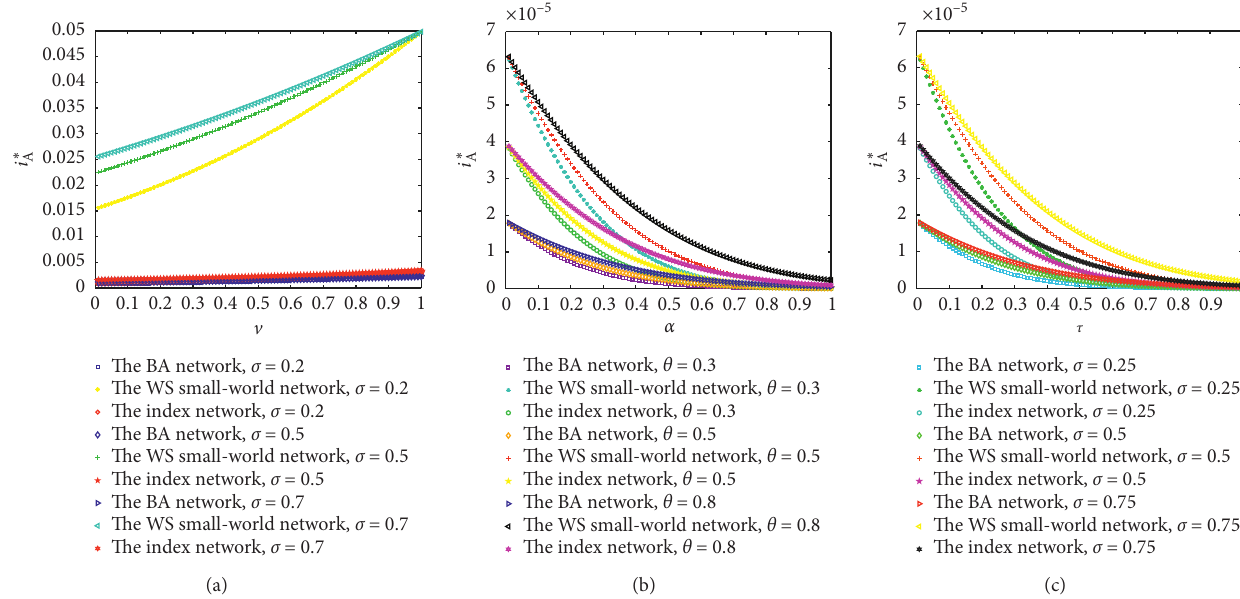
Figure 4: Evolutionary law of the scale of credit risk contagion of corporate counterparties. (a) The impact of the initial economic shock ] of the corporate counterparty on i ∗ A under the different network structures and the leverage level σ of different corporate counterparties. (b) The impact of the enterprise transaction counterparty’s risk perception level α on i ∗ A under the different network structures and the influence of different corporate counterparties θ . (c) The impact of the risk-overflow ability τ of corporate counterparties on i ∗ A under different network structures and the leverage level σ of different corporate